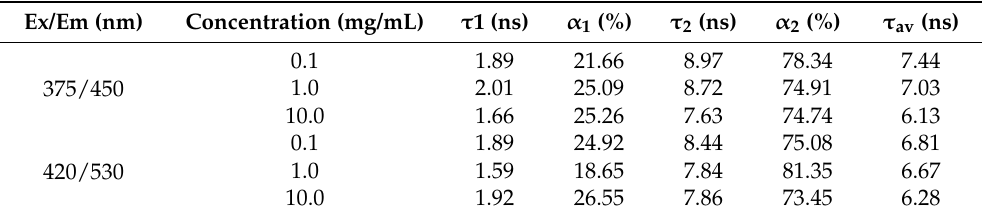
Table 1. Fluorescence lifetimes of PEI@CNDs solutions at different concentrations (0.1, 1.0, and 10.0 mg/mL) with 375 nm excitation, 450 nm monitoring, and 420 nm excitation, 530 monitoring,